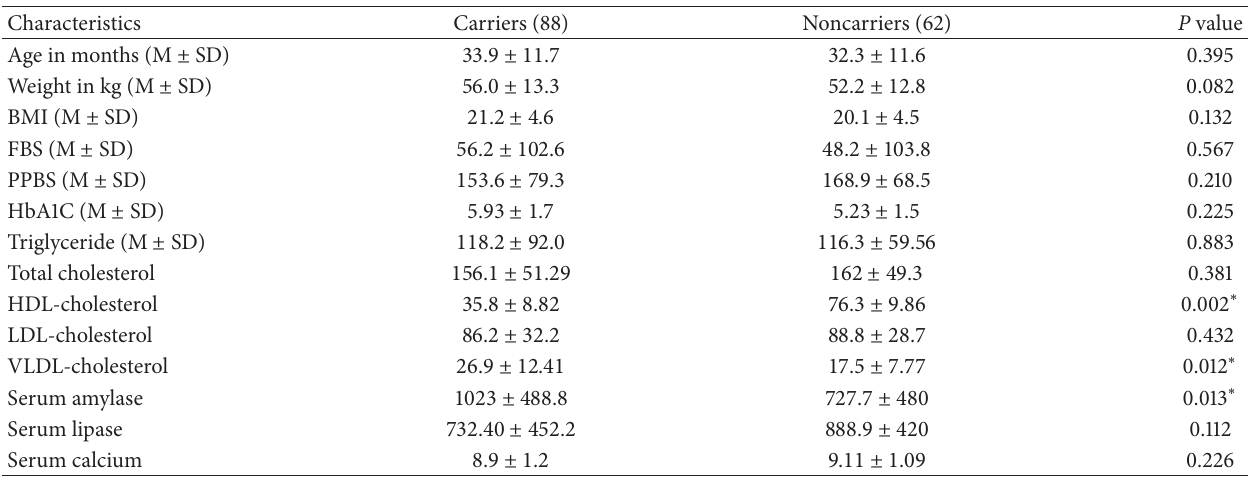
Table 2: Demographic and clinical profiles of 150 chronic pancreatitis cases (carriers versus noncarriers) screened for SPINK1 gene.